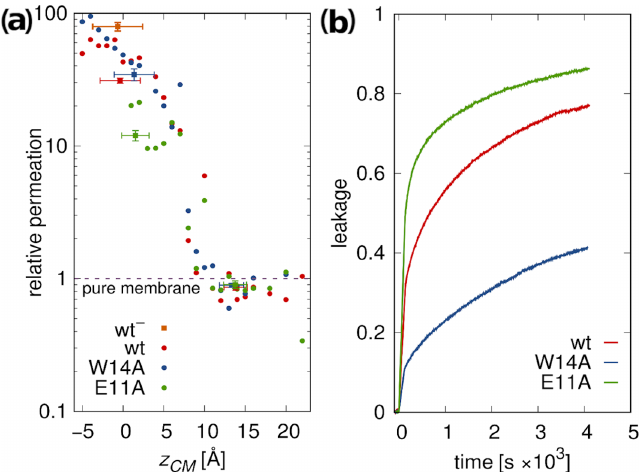
Figure 7. ( a ) POPC membrane water permeation for 1:162 peptide to lipid ratio, relative to pure membrane slab composed of 162 lipids. Dots correspond to values obtained from umbrella sampling simulations for restrained hairpin conformations, squares to values obtained from unrestrained simulations. ( b ) Peptide-induced calcein leakage from POPC